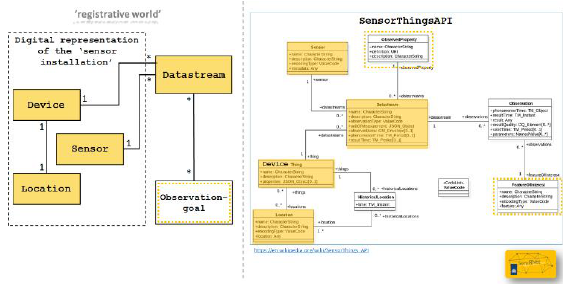
Figure 4 . SensRNet Data Model matching SensorThingsAPI